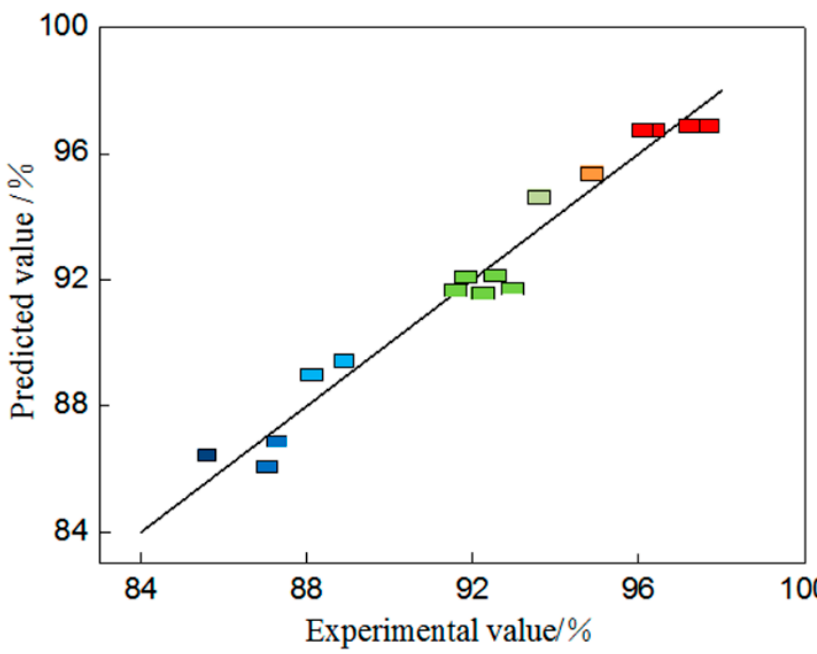
Figure 6. Diagram of the relationship between predicted values and actual values.